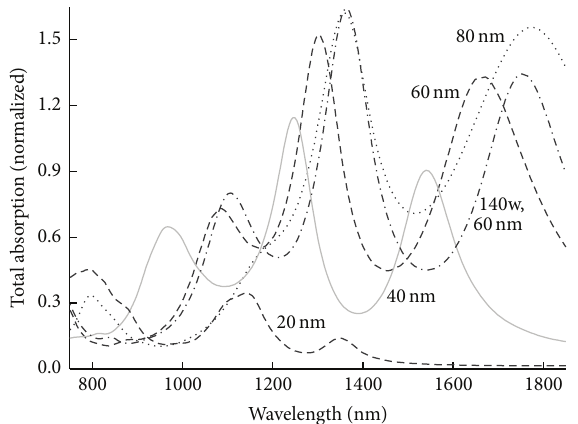
Figure 5: Total (silicon + silver) power absorption spectra for half- shell nanowires with heights from 20 to 80 nm. Width of these nanowires was 120nm. The trace marked as (140w, 60 nm) shows the spectrum for a (140 × 60) nanowire. Power absorption was normalized with respect to source